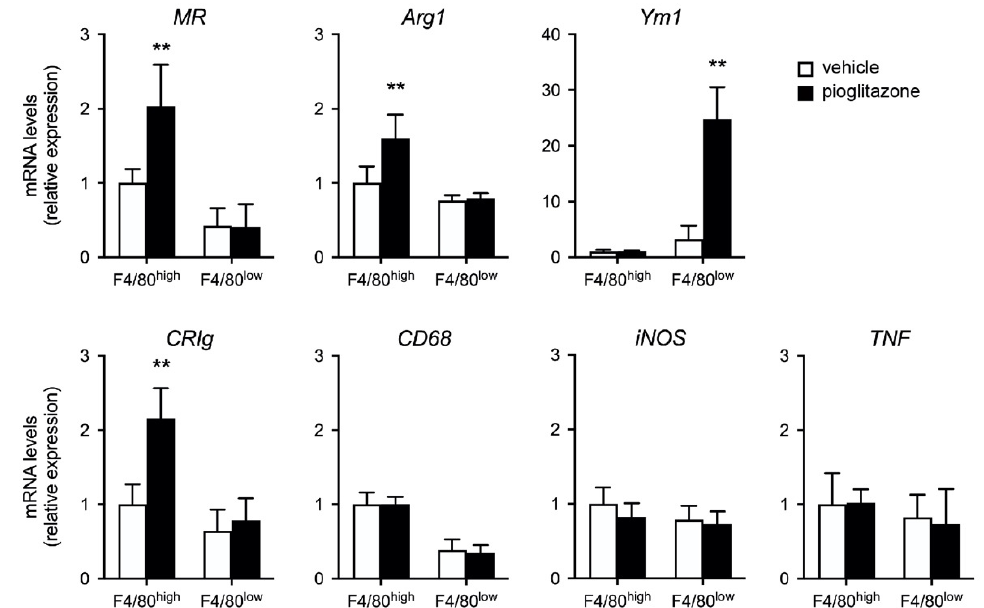
Figure 6. Pioglitazone induces M2 markers and CRIg in liver F4/80 + cells after burn injury in vivo. Gene expression changes in F4/80 high KCs and F4/80 low recruited (infiltrated) monocytes/macrophages. Five days after burn injury, indicated cell types were harvested from the vehicle and pioglitazone-treated mice 3 h after treatment and subjected to quantitative reverse transcription-polymerase chain reaction (qRT-PCR) analysis to determine the expression levels of macrophages M1/M2 markers. All values were normalized for ribosomal protein S18 ( Rps18 ) and are presented relative to F4/80 high KCs from vehicle-treated mice. n = 4 per group. Data are represented as the mean ± SD; ** p < 0.01 vs. vehicle.